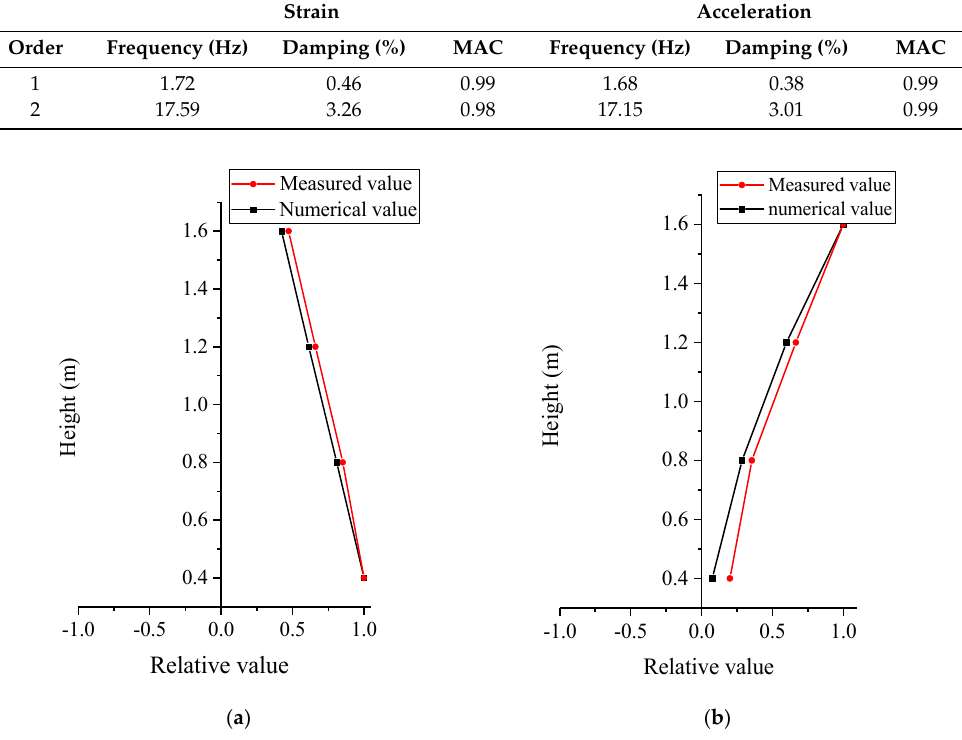
Figure 6. Comparison of the experimental and simulated mode shapes estimated by both the acceleration and strain responses. ( a ) First strain-based mode shape; ( b ) first acceleration-based mode shape.